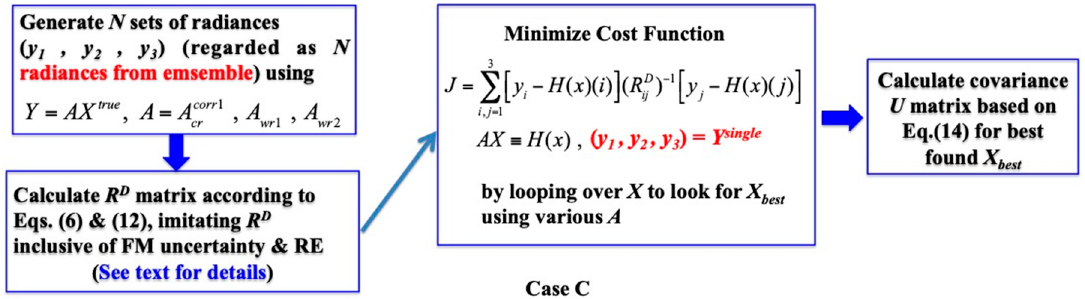
Figure 7. Analysis procedures for Cases C, where FM uncertainty and RE stand for forward model uncertainty and representativeness error, respectively.